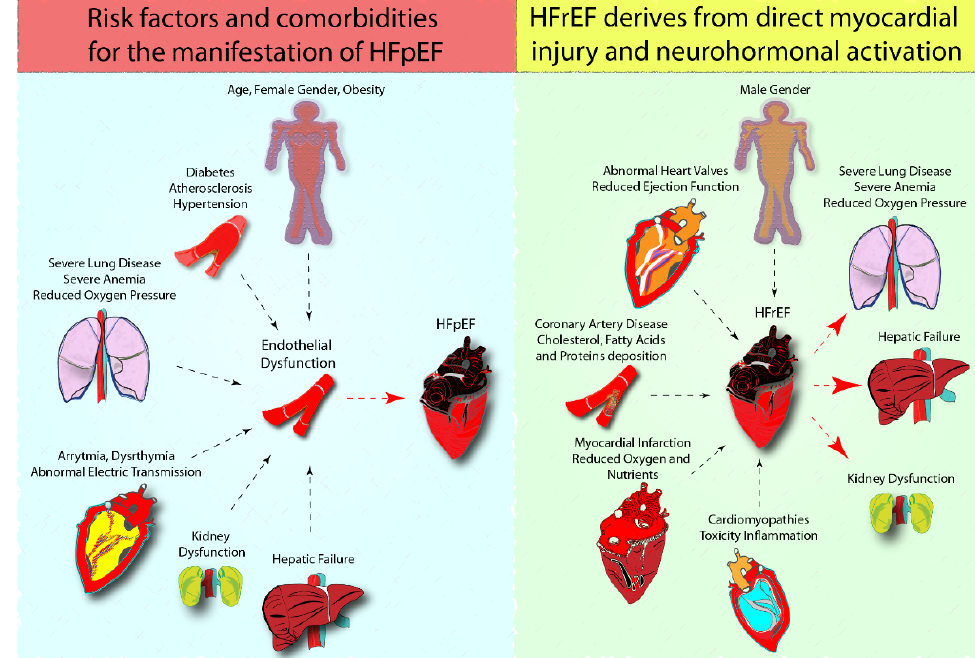
Figure 1. Correlation of HFpEF and HFrEF with microvascular dysfunction and direct myocardial injury, and neurohormonal activation. HFpEF is a complex clinical heterogeneous syndrome. An emerging paradigm emphasizes that HFpEF onset is favored by the combination of contributing risk factors (aging, female gender, obesity) and comorbidities (atrial fibrillation, hypertension, diabetes, kidney dysfunction, and chronic obstructive pulmonary disease), which cause endothelial dysfunction.